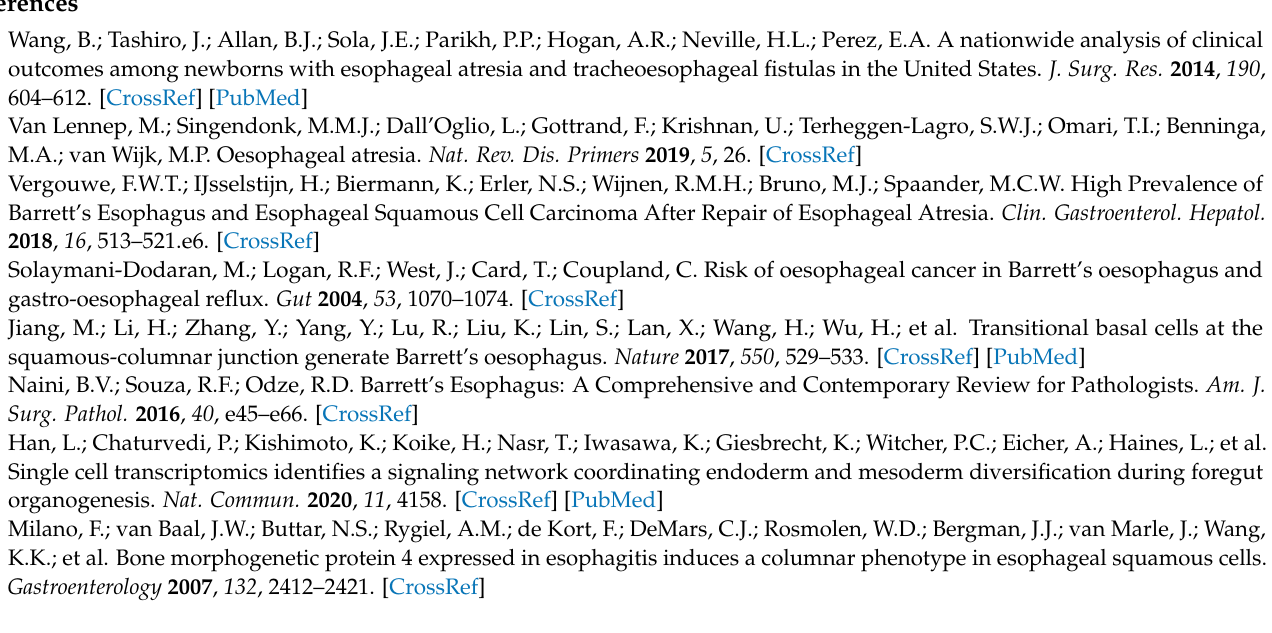
and healthy controls. Figure S8: Violin plots of gastroesophageal (GEJ) samples and box plots of acid-exposed fibroblasts. Figure S9. SPINK1 is a potential BE biomarker. Datafile S1: Individual